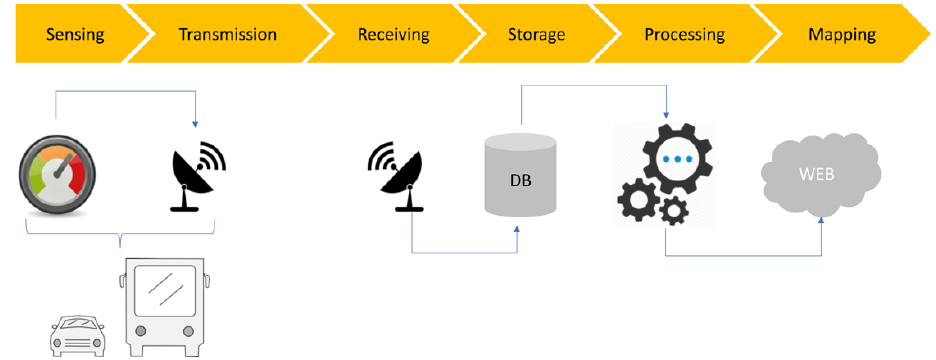
Figure 1. Scheme of the COCAL system and infrastructure. COCAL boxes are installed on buses and cars that contain air quality sensors and transmission devices. Data is transmitted through the mobile phone network and sent to an OGS storage and processing facility. Data products are visualized on the project’s web portal (https://cocal.ogs.it accessed on 1 November 2022).